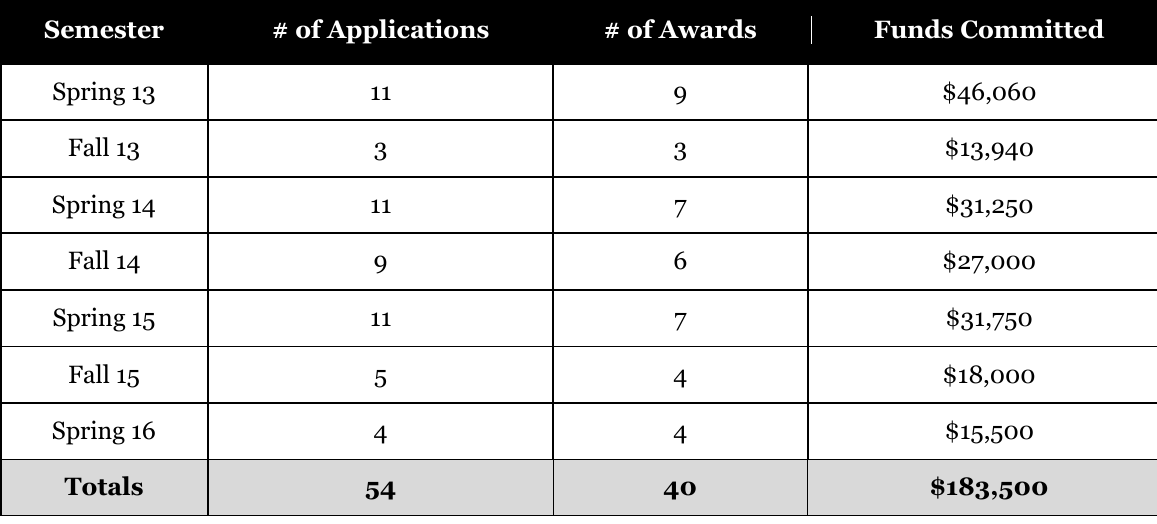
Number of Applications, Awards, and Funds Committed During the 3.5 Years of the Initiative Semester # of Applications # of Awards Funds